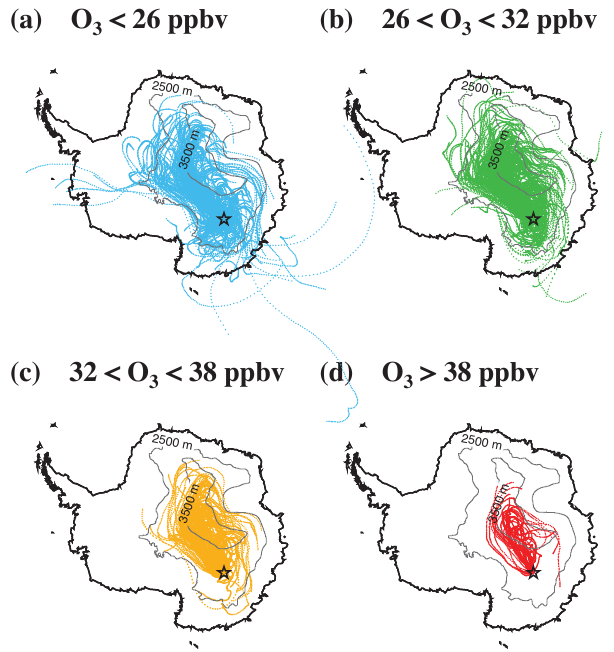
Figure 6. The 5-day backward trajectories for December at Con- cordia (from 2007 to 2014) corresponding to ozone mixing ratios of less than 26ppbv (blue lines in a ), ranging between 26 and 32ppbv (green lines in b ), between 32 and 38ppbv (yellow lines in c ), and higher than 38ppbv (red lines in d ). All lines correspond to arrivals at 0ma.g.l.